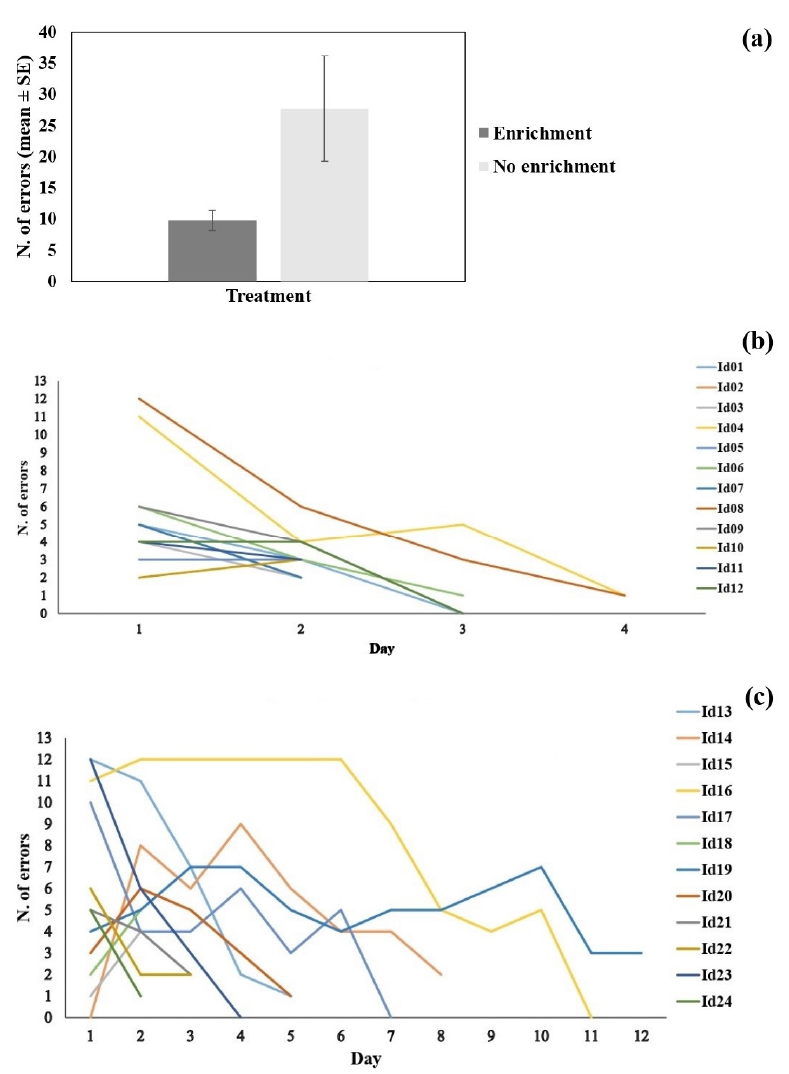
Figure 3. Result of discrimination learning task. ( a ) The number of errors to reach the learning criterion (mean ± SE) divided per treatment; the dark bar shows the subjects of the enriched treatment and the light bar the subjects without enrichment. ( b ) The number of errors made in each day of testing by the fish of the enriched treatment; each line corresponds to an experimental subject. ( c ) The number of errors made in each day of testing by the fish of the treatment without enrichment; each line corresponds to an experimental subject.